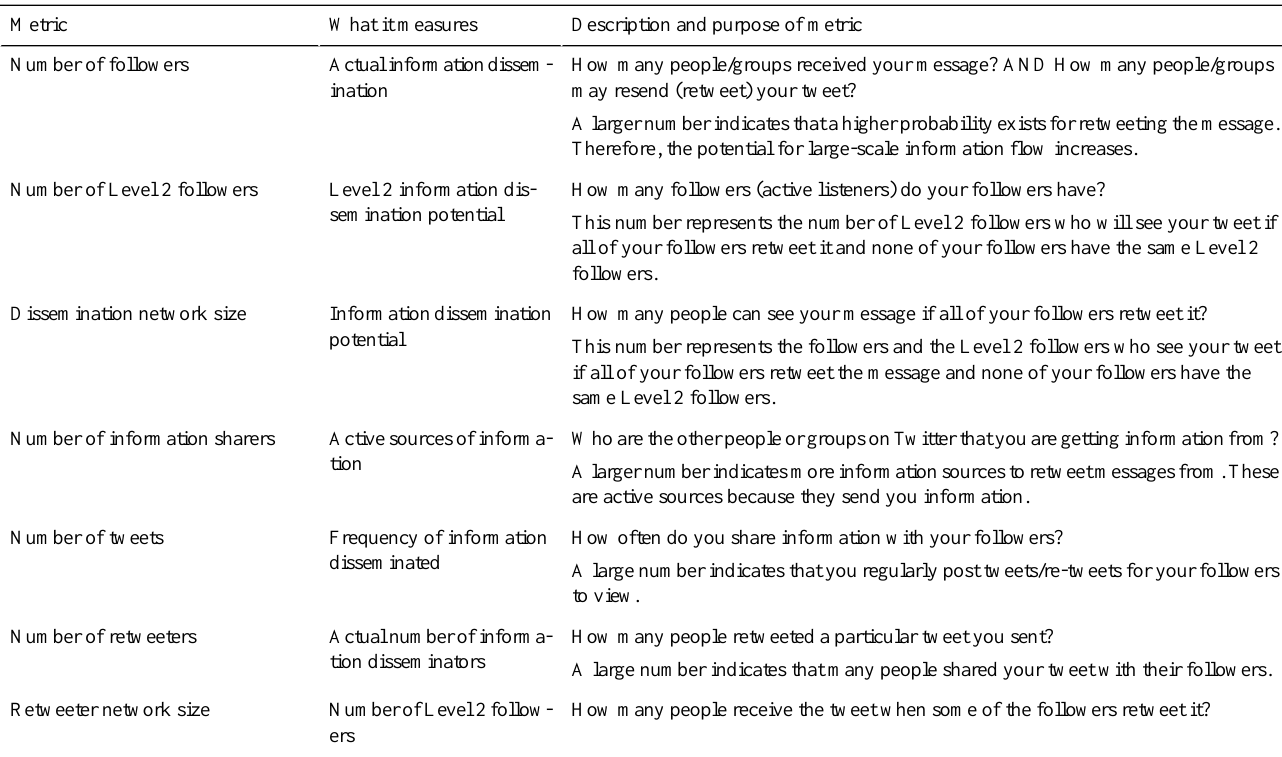
Table 1. Description of metrics from Twitter. Description and purpose of metricWhat it measuresMetric How many people/groups received your message? AND How many people/groups information dissem- inationNumber of followers may resend (retweet) your tweet? A larger number indicates that a higher probability exists for retweeting the message. Therefore, the potential for large-scale information flow How many followers (active listeners) do your followers have? followers.Level 2 information dis- potentialNumber of Level 2 followers semination This number represents the number of Level 2 followers who will see your tweet if all of your followers retweet it and none of your followers have the same Level 2 How many people can see your message if all of your followers retweet it? This number represents the followers and the Level 2 followers who see your tweet if all of your followers retweet the message and none of your followers have the same Level 2 Who are the other people or groups on Twitter that you are getting information from? A larger number indicates more information sources to retweet messages from. These are active sources because they send you A large number indicates that you regularly post tweets/re-tweets for your followers